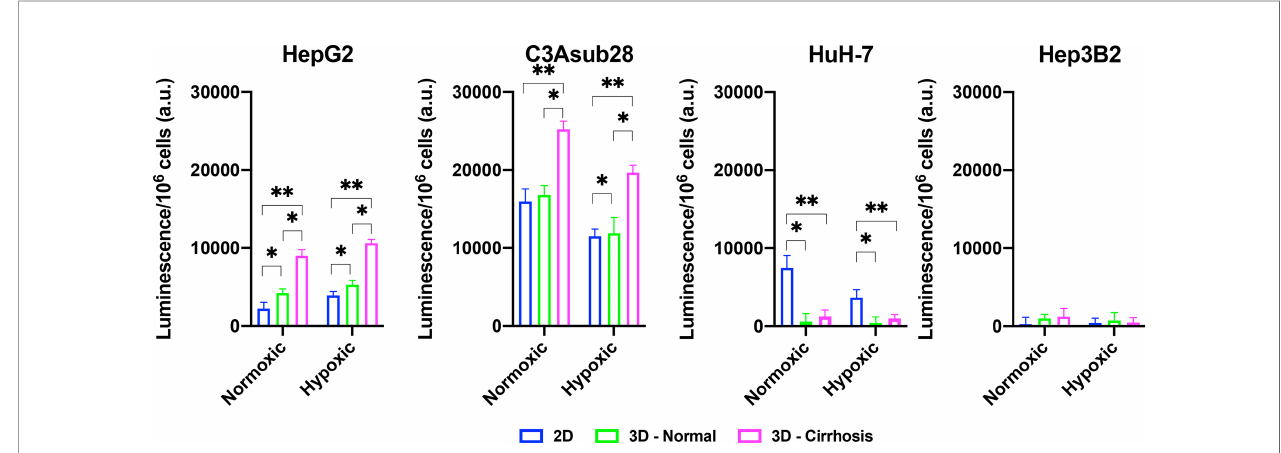
FIGURE 5 | Regulation of CYP3A4 is responsible for drug metabolization by HCC cell lines in response to hypoxic and cirrhotic conditions. Presence of cirrhosis and hypoxia altered CYP3A4 activity differently between HCC cell lines. Data represented as mean ± standard deviation. * denotes signi fi cance for cirrhotic and normal 3D samples compared to the 2D monolayer. *p < 0.05, **p <